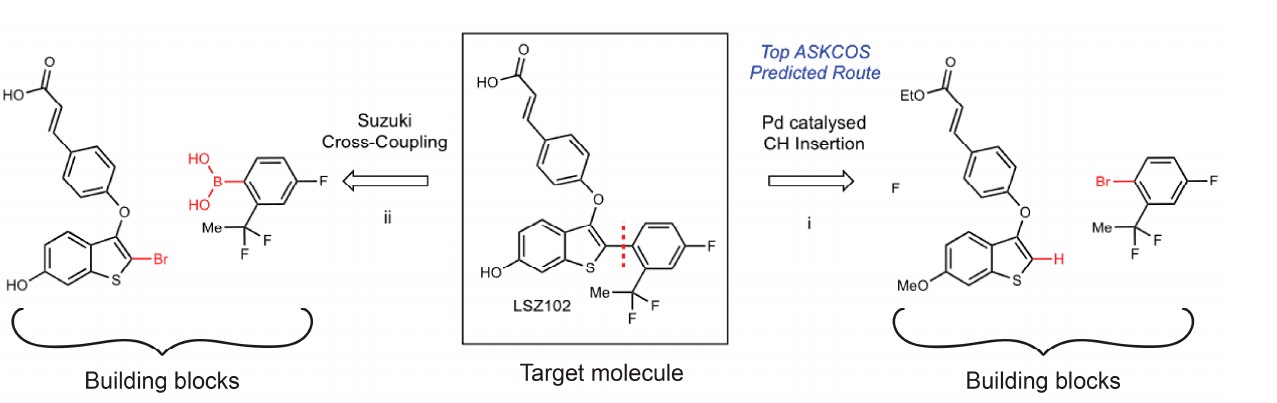
Figure 11. Retrosynthetic predictions for a bioactive molecule (LSZ102) by machine learning: (i) C − H insertion and (ii) C-H insertion, adapted under a Creative Commons Attribution 4.0 License from [91] (p. 8674) © 2020 American Chemical Society.